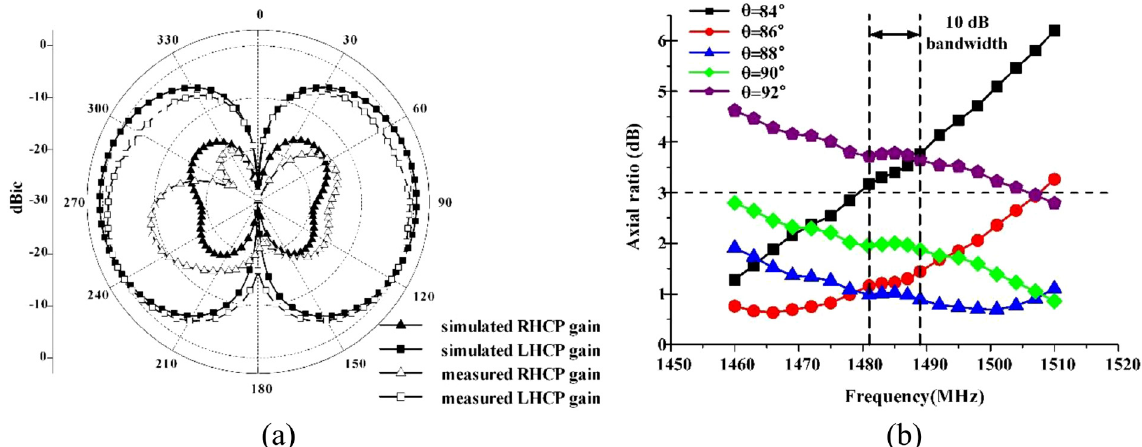
Fig. 9. (a) Simulated and measured radiation pattern ( x – z plane). (b) Measured average axial ratio ( u = 84 ° , 86 ° , 88 ° , 90 ° , and 92 ° ) vs. frequency. Figure 11b. To optimize the transfer ef fi ciency of the WPT